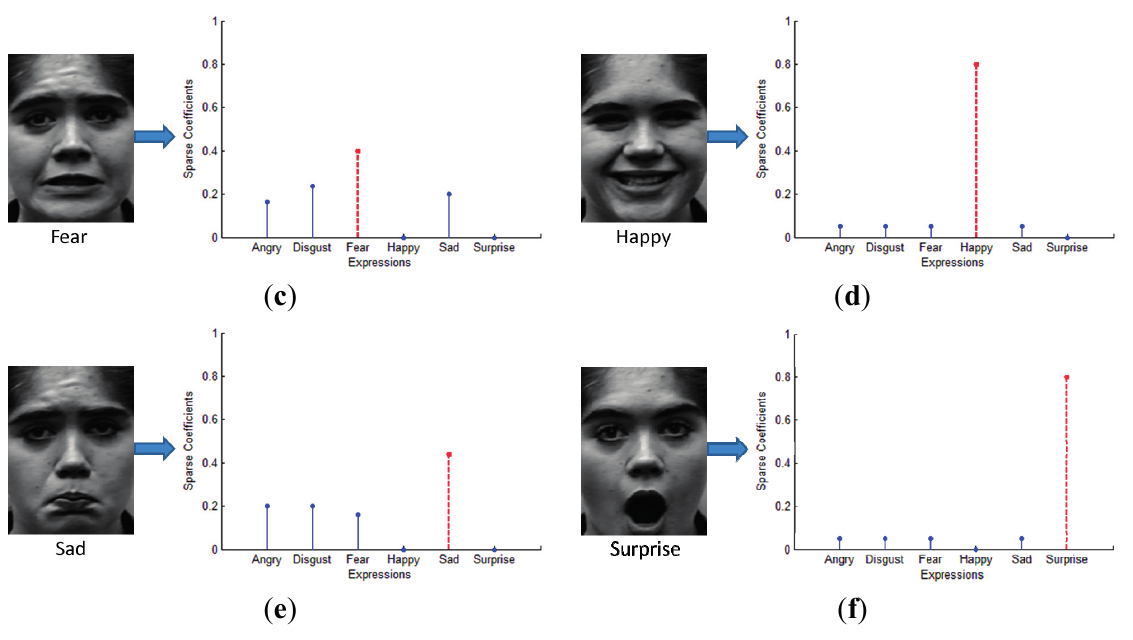
Figure 3. Classification result for different testing expressions ( a ) Angry; ( b ) Disgust; ( c ) Fear; ( d ) Happy; ( e ) Sad; ( f ) Surprise.